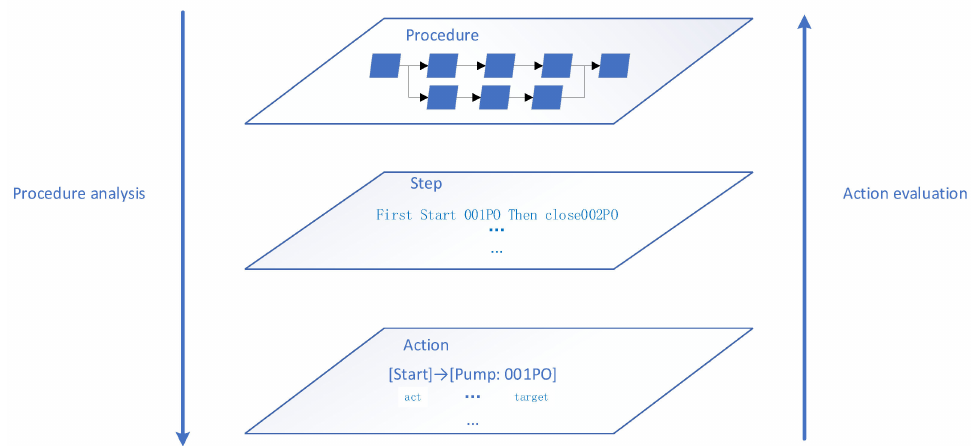
Figure 3. Multilevel structure of an MSM model.